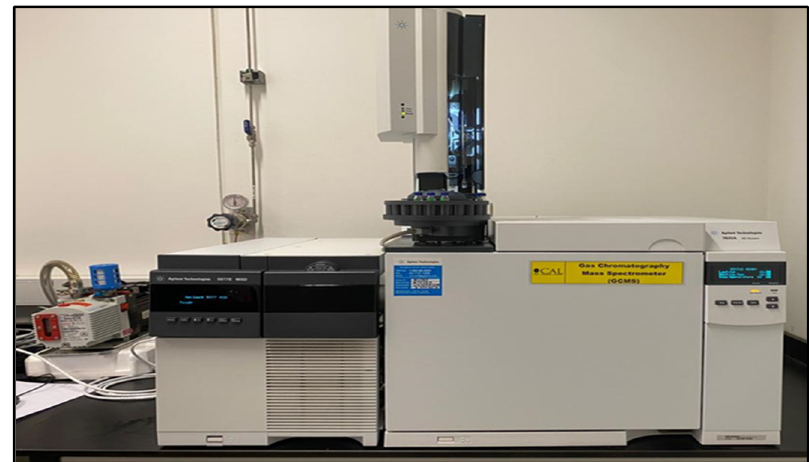
Figure 5. GCMS equipment.